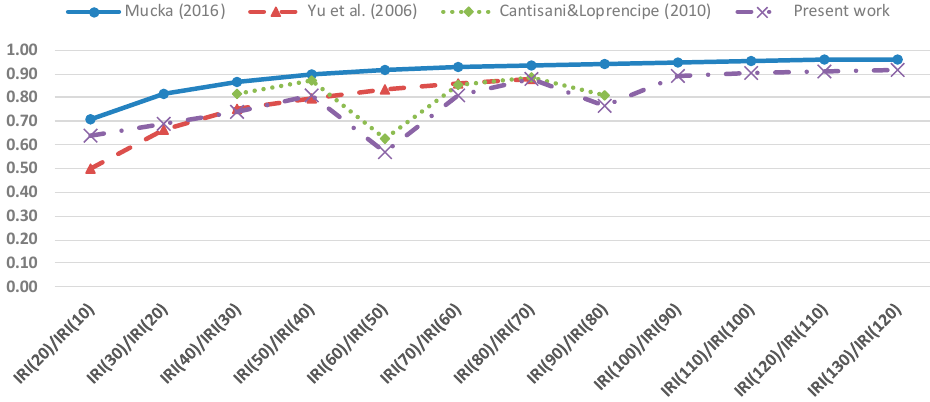
Figure 1. Ratio between IRI thresholds at different speeds provided by various studies.